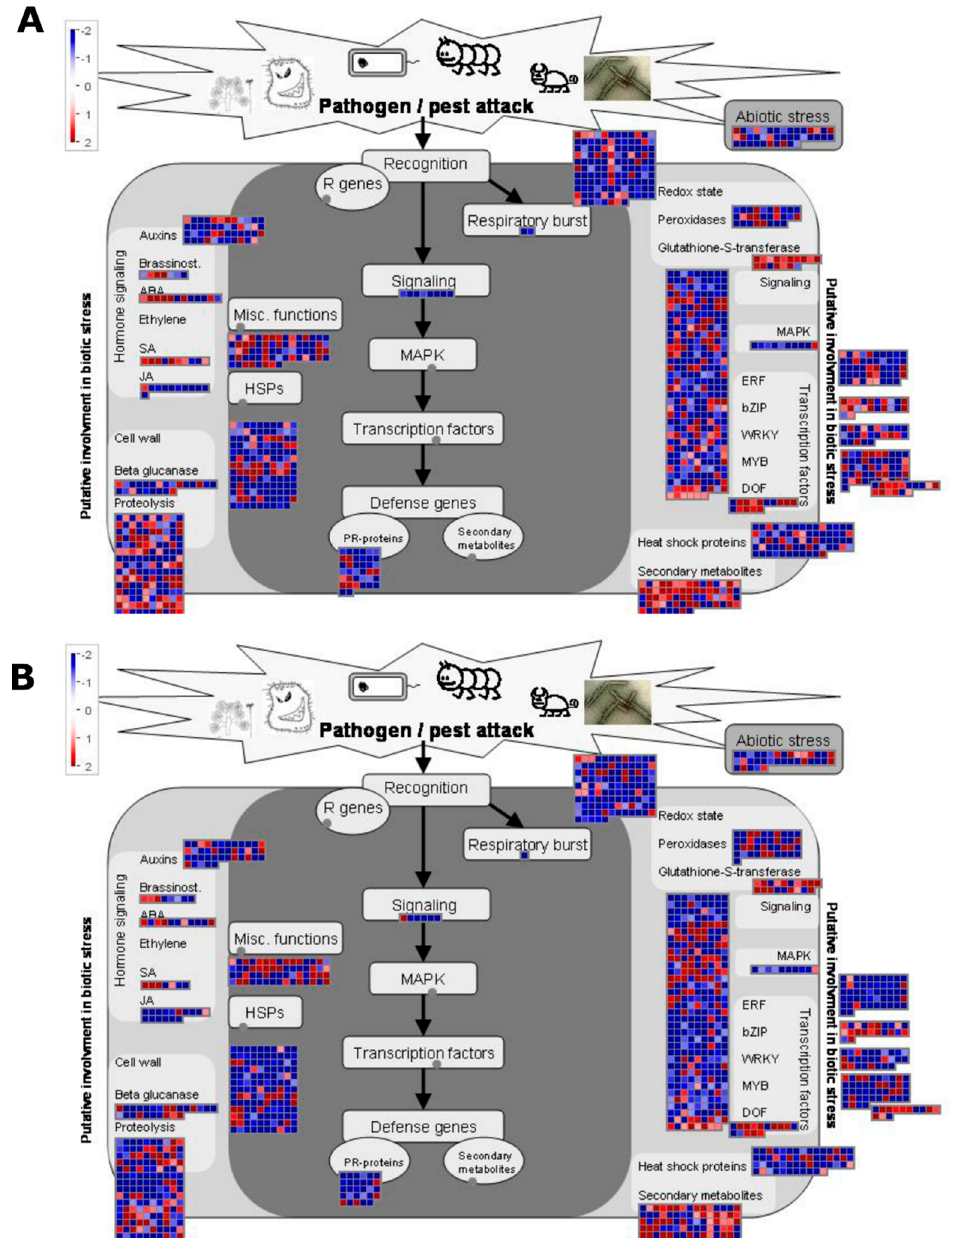
Figure 4. Transcriptional changes during responses of Solanum tuberosum cv. Mondial to Meloidogyne javanica infestation. ManMap visualization of genes related to biotic stress responses at 3 dpi ( A ) and 7 dpi ( B ). The modulation of 1471 and 1408 genes at 3 and 7 dpi, respectively, represents a set of genes important for early Meloidogyne javanica parasitism. The color-scale shown on the top left: red, up-regulated, and blue, down-regulated depicts the log 2 fold-change of gene expression signal. The grey filled circle represents functional classifications to which no genes were mapped.